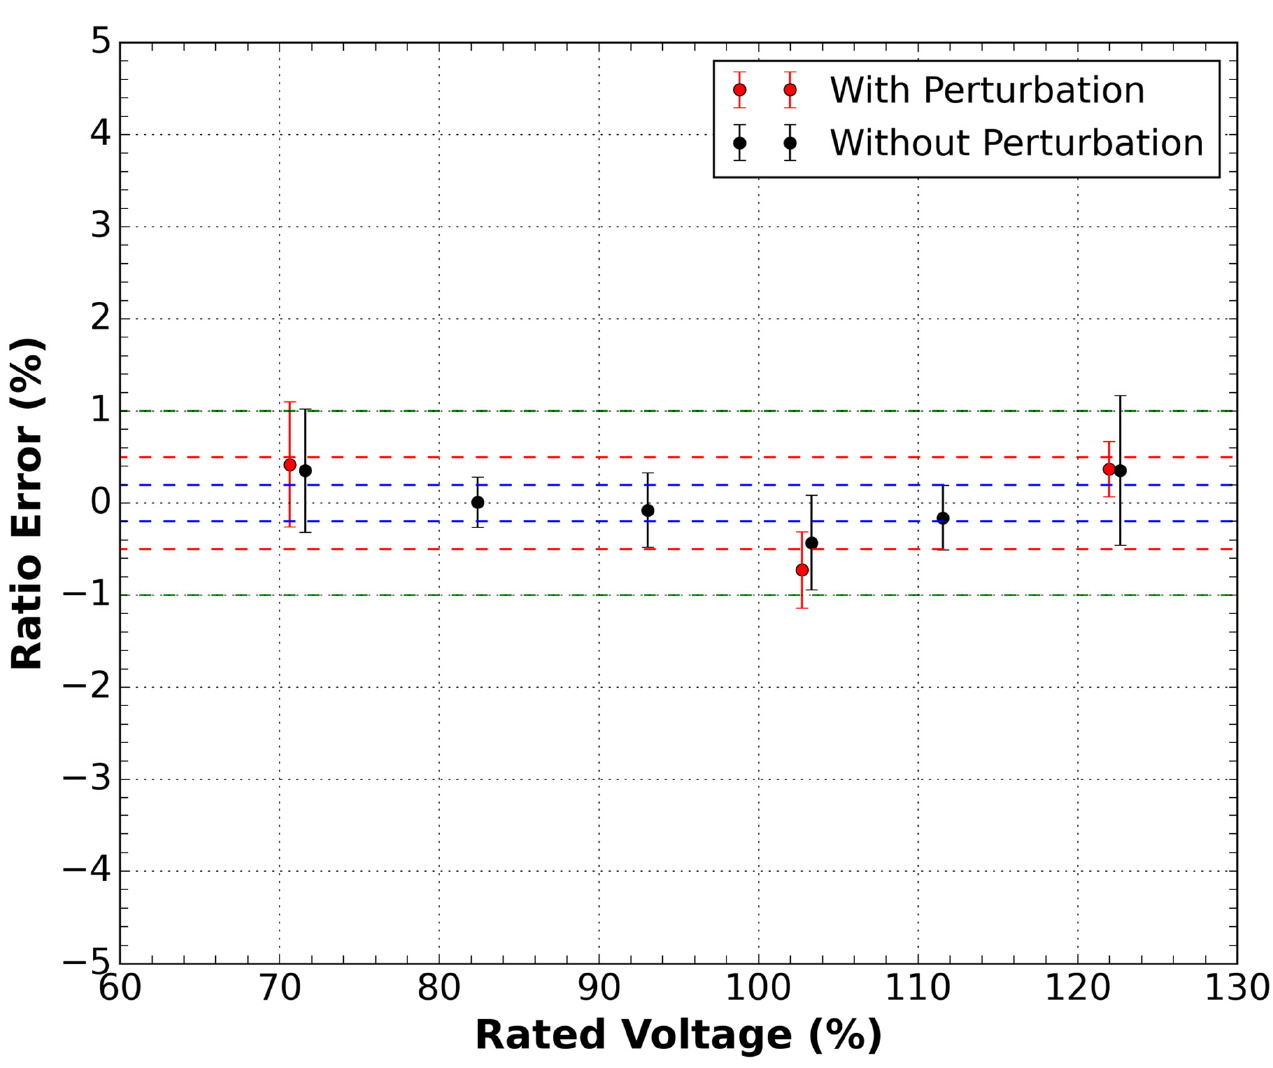
Figure 10. Ratio error measurements as a function of the rated voltage for the sensor inside the DWDM network for the conditions with and without disturbance in the optical cable of the sensor. Green dashed lines are the 1.0 class limits, red dashed lines are the 0.5 class limits, and the blue dashed lines are the 0.2 class limits.